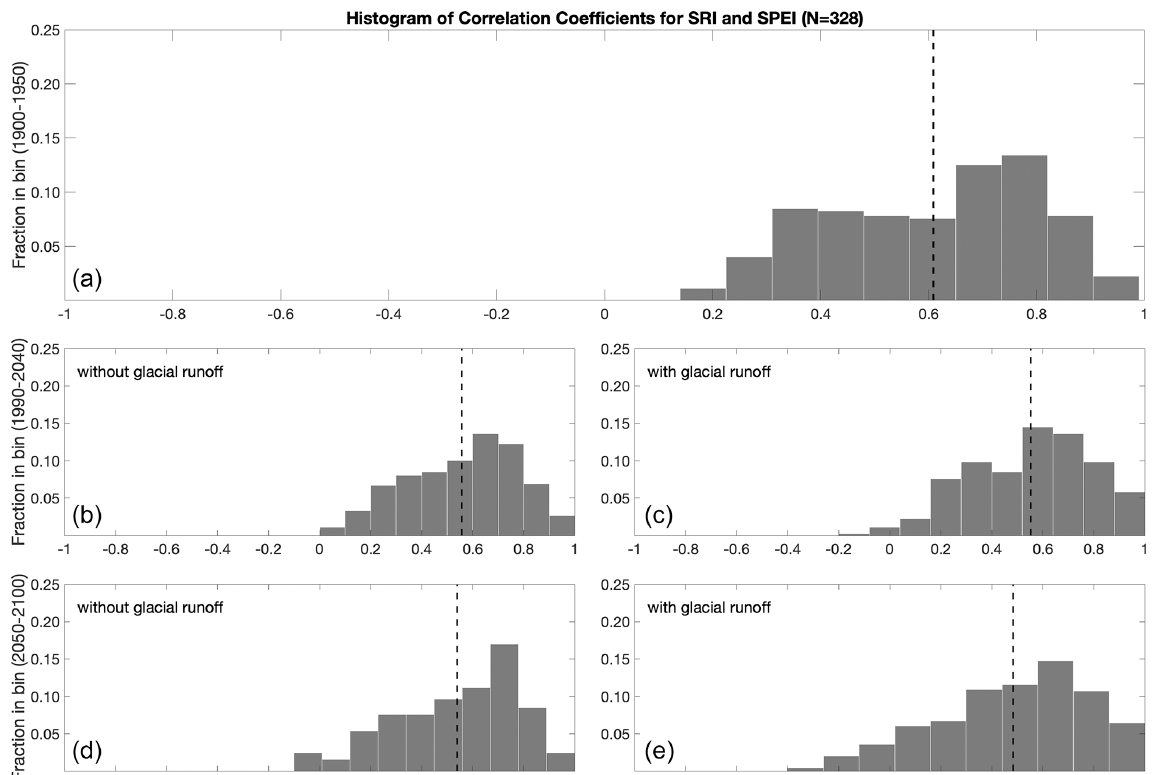
Figure C1. Histograms of correlation coefficients between the Standardized Runoff Indicator (SRI) and the SPEI, computed over three time periods. (a) 1900–1950, when there is no glacier model input available. (b, c) 1990–2040, correlating the SRI with SPEI N (b) and SPEI G (c) . (d, e) : 2050–2100, correlating the SRI with SPEI N (d) and SPEI G (e) . Dashed lines indicate median correlation values.